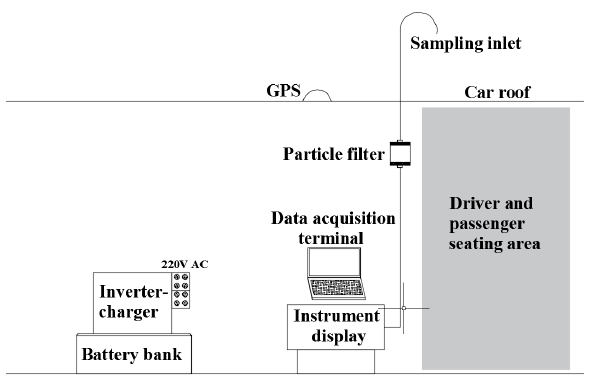
Figure 1. Schematic of the mobile observatory. The viewing angle is from the passenger side of the